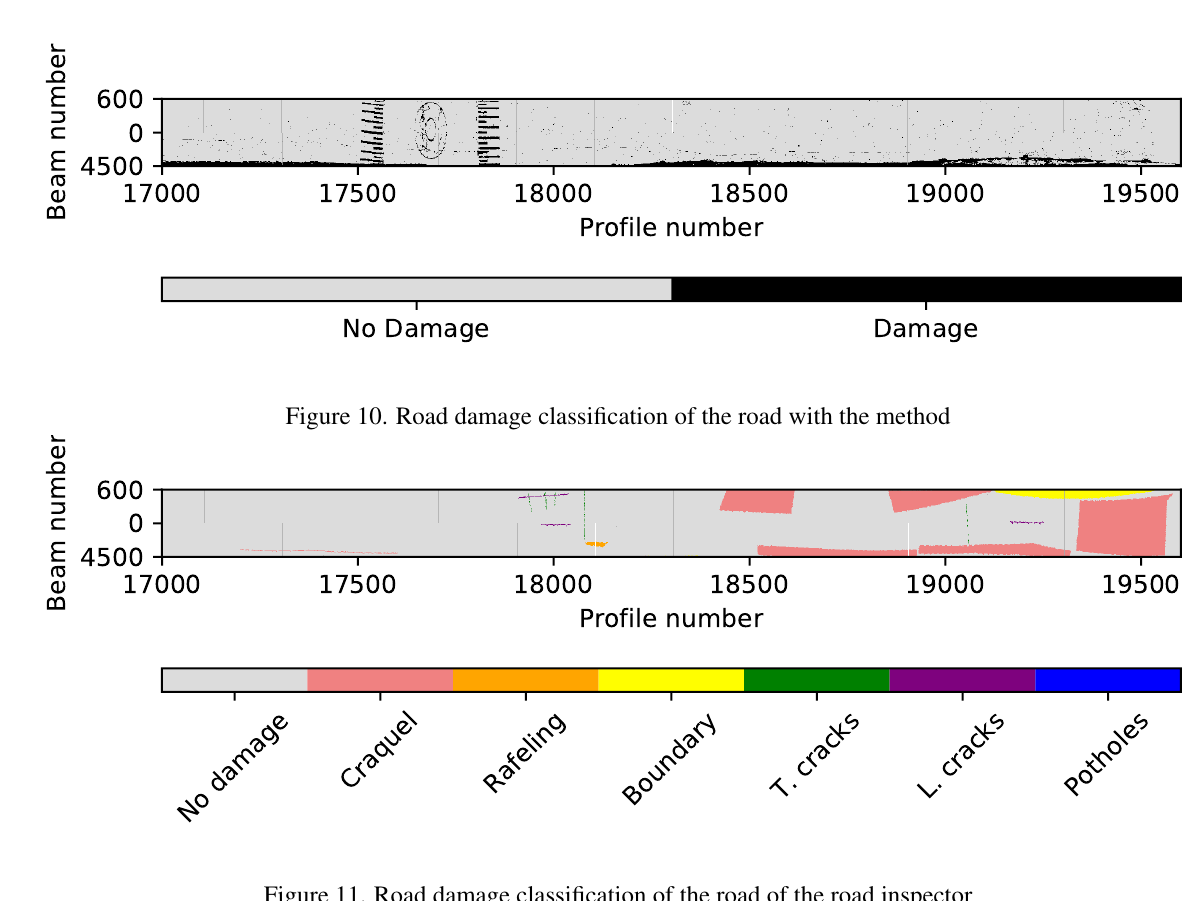
Figure 11. Road damage classification of the road of the road inspector